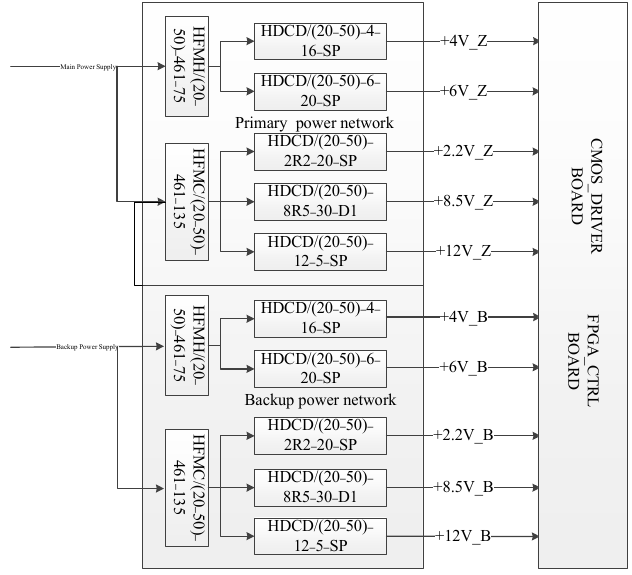
Figure 4. The camera secondary power supply block diagram.